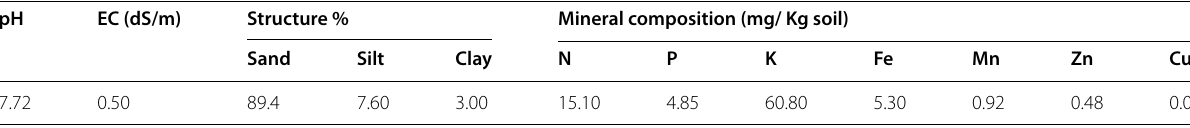
Table 1 Some chemical and physical characteristics of the soil pH EC